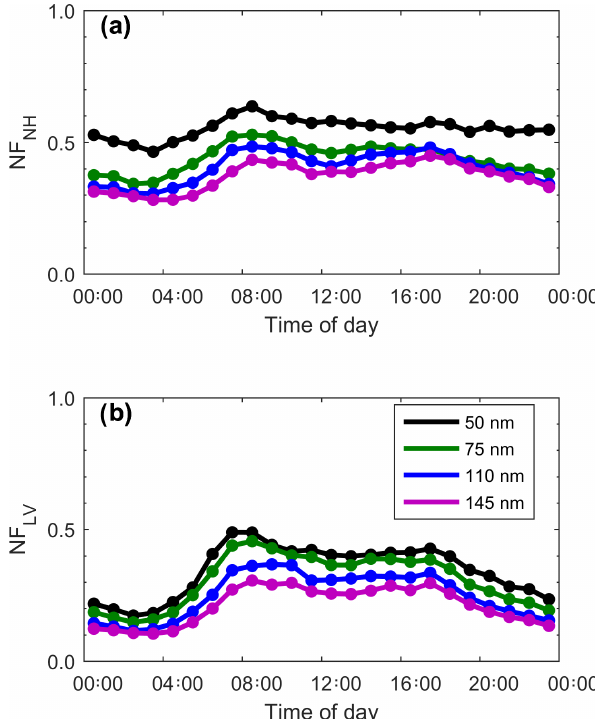
Figure 3. Mean diurnal variation of the number fraction of parti- cles in the nearly hydrophobic mode (NF NH ; a ) and less volatile mode (NF LV ; b ) for different dry particle diameters. The panels have shared